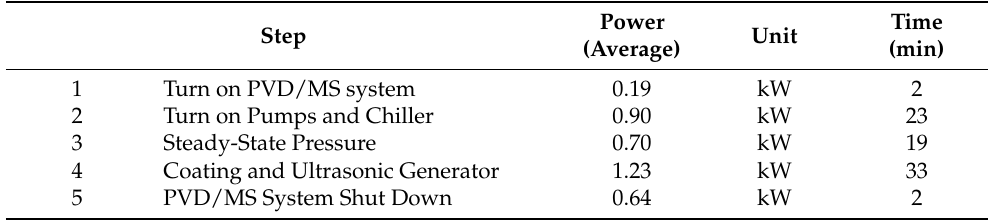
Table 4. Stepwise Average Power Consumption for PVD/MS